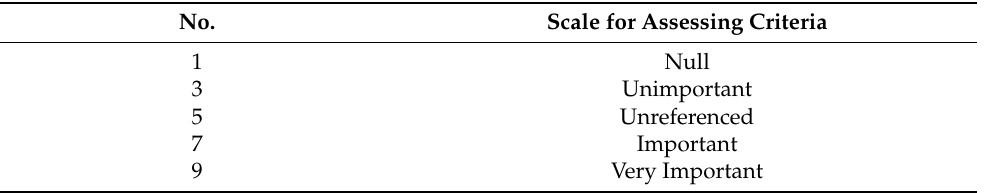
Table 2. Criteria for assessing the contribution of each component to each of the C i indicators that comprise the CMI.